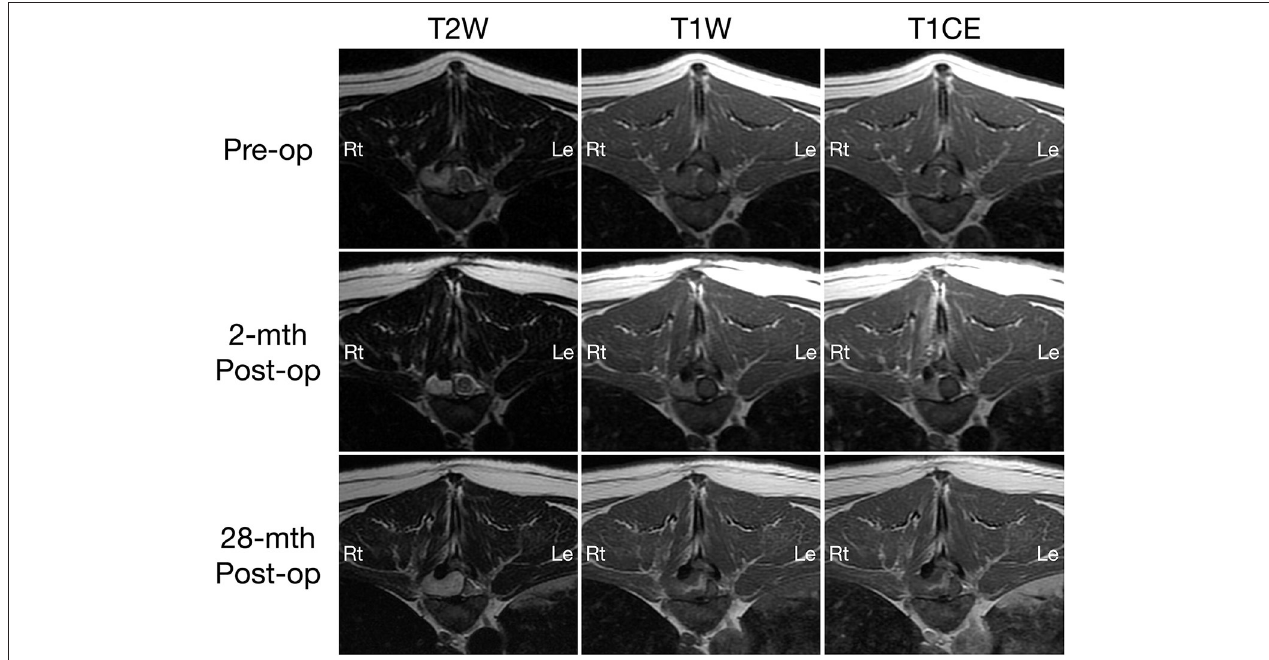
FIGURE 1 | Transverse T2-weighted (left column) and pre- (middle column) and post-contrast T1W (right column) MRI images of a dog with extradural spinal epidermoid cyst; pre-operative (top row) and 2-month (middle row) or 28-month post-operative (bottom row) at the level of T9-T10 intervertebral disc space.